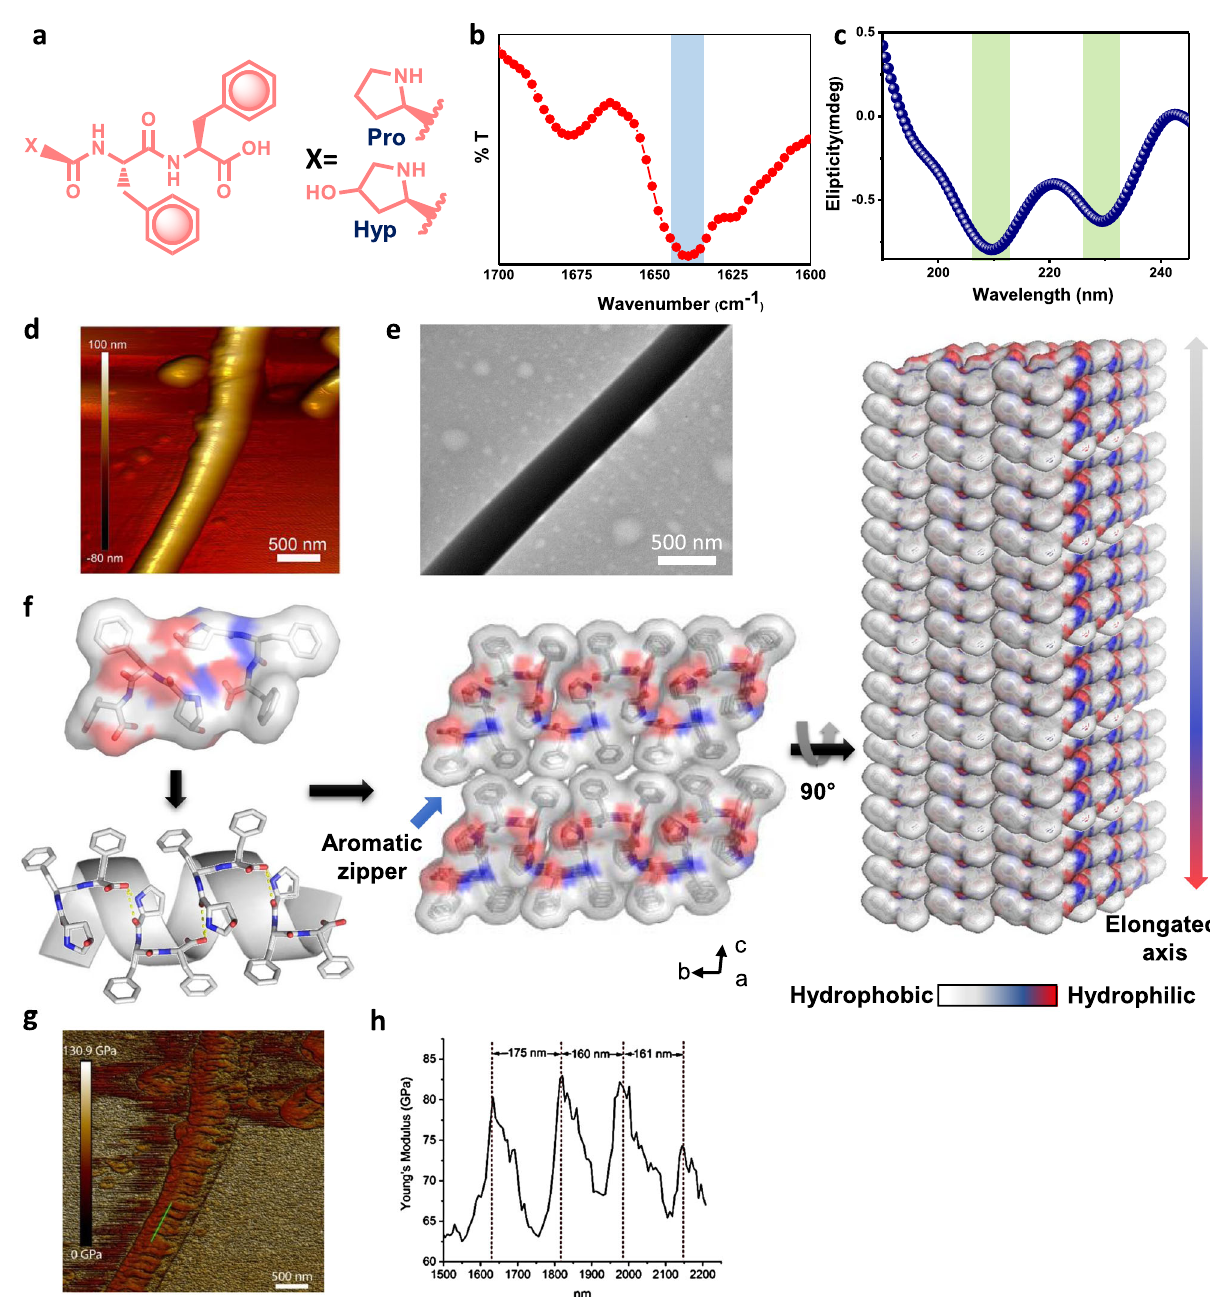
Fig. 1 Self-assembly and structural characterization of Hyp-Phe-Phe. a Chemical structure of Pro-Phe-Phe and Hyp-Phe-Phe. b FTIR analysis of Hyp-Phe- Phe assemblies showing the characteristic peak of helical conformation. c CD spectrum of the tripeptide reveals the presence of helical assemblies in solution. d AFM image of the tripeptide demonstrating fi brillar morphology. e TEM image of the tripeptide fi bres. f Single-crystal structure of Hyp-Phe-Phe showing the formation of an elongated structure by stacking of helices through intermolecular hydrogen bonding and aromatic zipper-like packing. CCDC ref. no. 1823367 26 . g , h Mechanical strength of the Hyp-Phe-Phe fi bres. g Nanoscale mapping of Young ’ s modulus ( Z -scale = 140 GPa). h Line section through one fi bril as highlighted by the green line in g , showing the periodic variation in stiffness along the fi bril. Additional AFM and TEM data are given in Supplementary Figs. 1 –